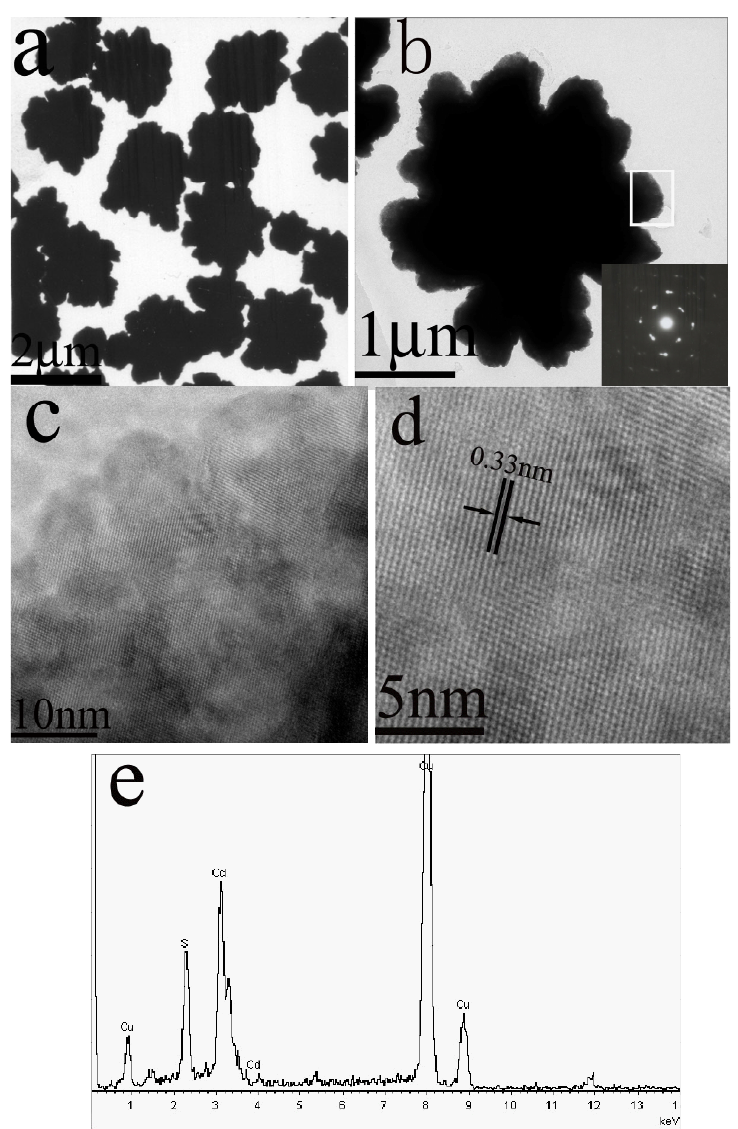
Figure 3. (a) TEM image of flower-like CdS architectures; (b) TEM image of a flower-like CdS architecture, and its SAED pattern (inset); (c) high resolution TEM image of the selected area in Fig. 2b; (d) HRTEM image of the edge of a petal in Fig. 3 c; (e) EDS spectrum of the flower-like CdS